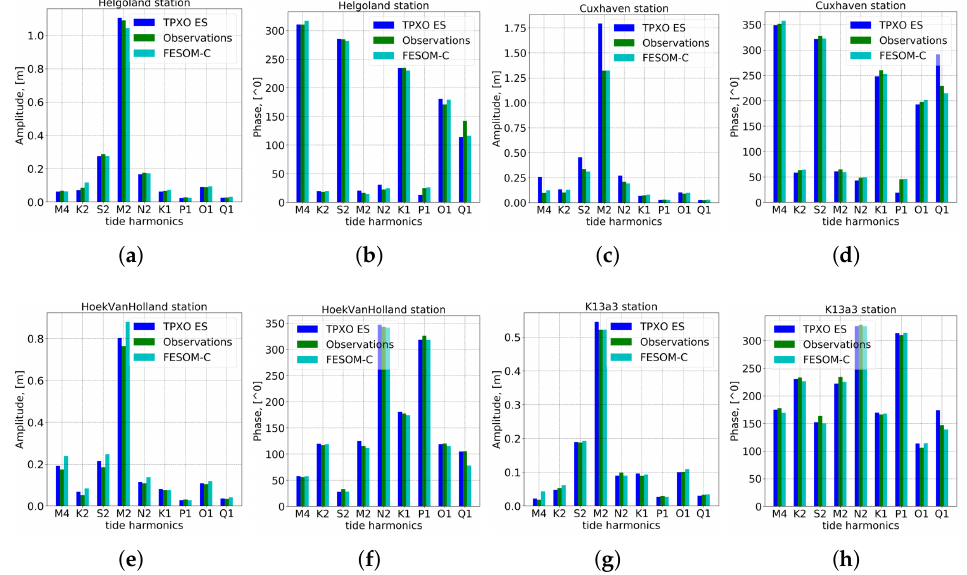
Figure 3. Amplitudes ( a , c , e , g ) (meters) and phases ( b , d , f , h ) (degrees) of the nine main tidal harmonics at four stations in the modeled area. Green shows the calculated ([50]) values based on observed sea surface elevation during the years 2010–2014. Blue shows the regional (European Shelf 1/30 ◦ ) tidal solutions of the TPXO tidal model. Cyan shows FESOM-C model results processed in a way similar to the